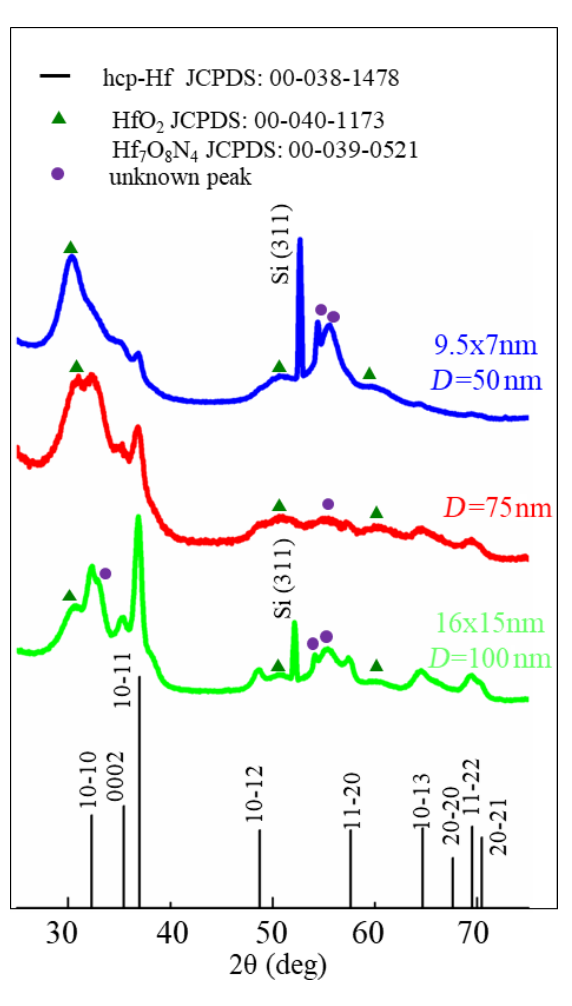
Figure 3: X-ray pattern of hafnium NPs on Si substrate synthesized for different aggregation-zone lengths D = 50, 75 and 100 nm.